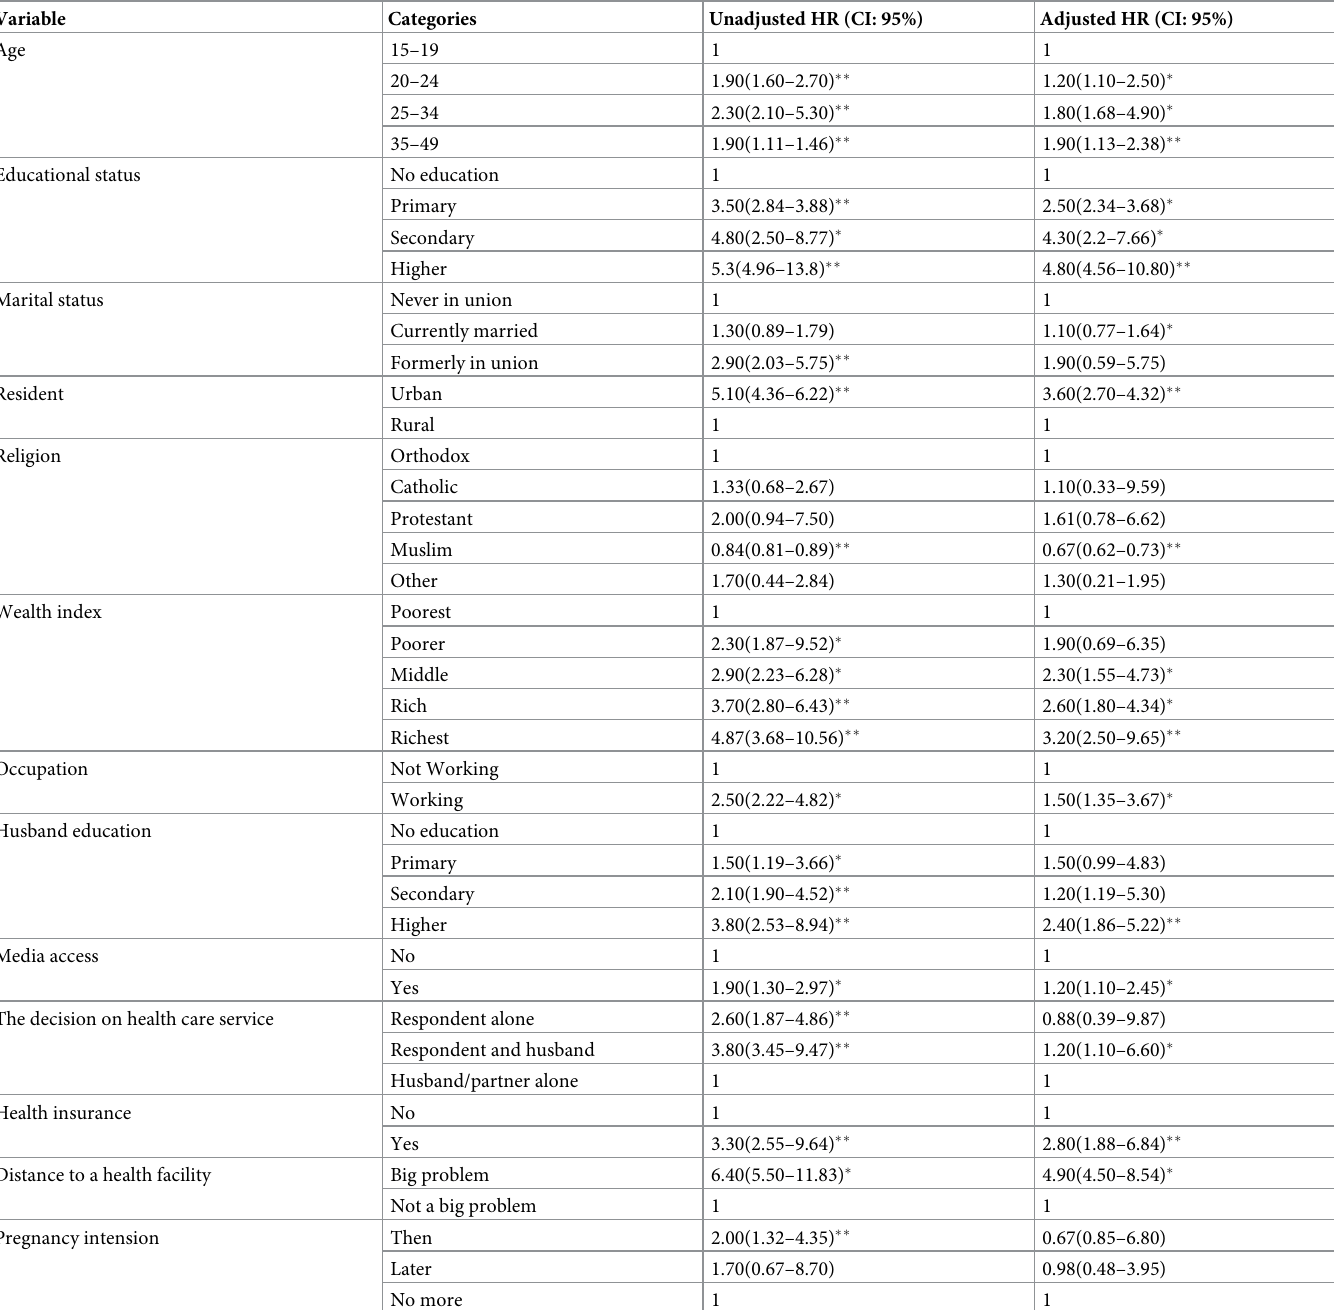
Table 2. Univariate and multivariate cox-regression analysis showing predictors of timing of first antenatal care visit in